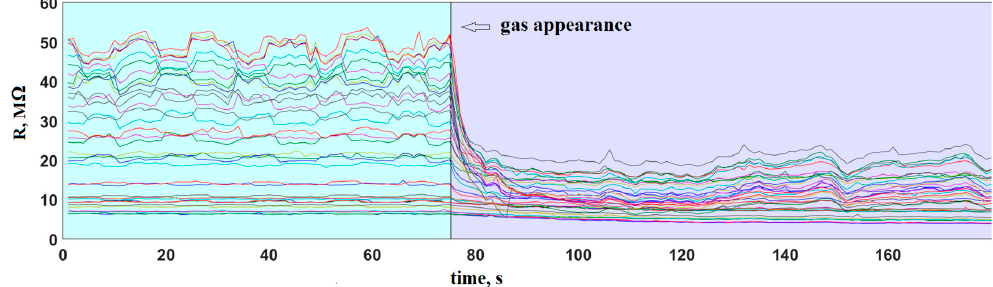
Figure 7. A typical R ( t ) behavior of the array segments in the e-nose during an event of its exposure to fuel gas emitted by a lighter. The resistance curves of different segments are marked with different colors. The arrow points the moment of gas appearance.